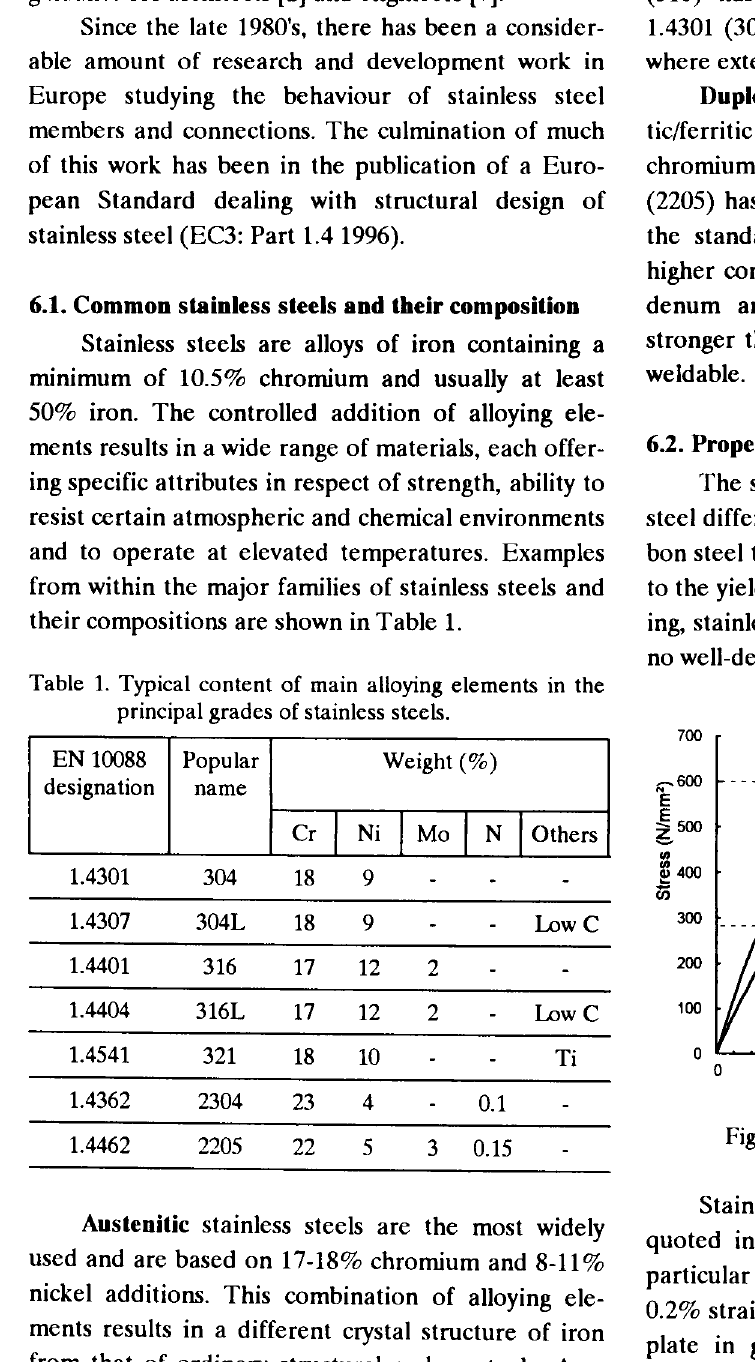
Fig 12. Stress-strain curves for stailess